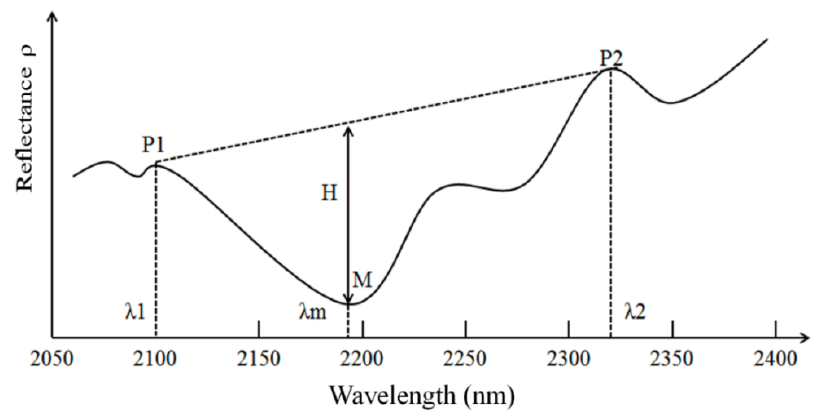
Figure 4. Spectral absorption features and SAI index model